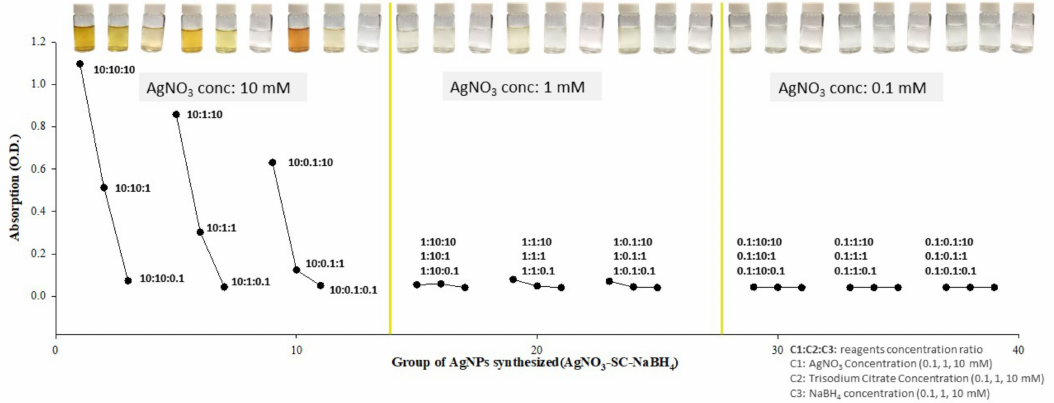
Figure 5. UV–Vis spectra of different concentrations at the wavelength of 400 nm for AgNPs generated using three reagents (silver nitrate, trisodium citrate, and sodium borohydride). Each dot represents a different reagent concentration ratio (silver nitrate/trisodium citrate/sodium borohydride); namely, 10:10:10, 10:10:1, 10:10:0.1, . . . , and